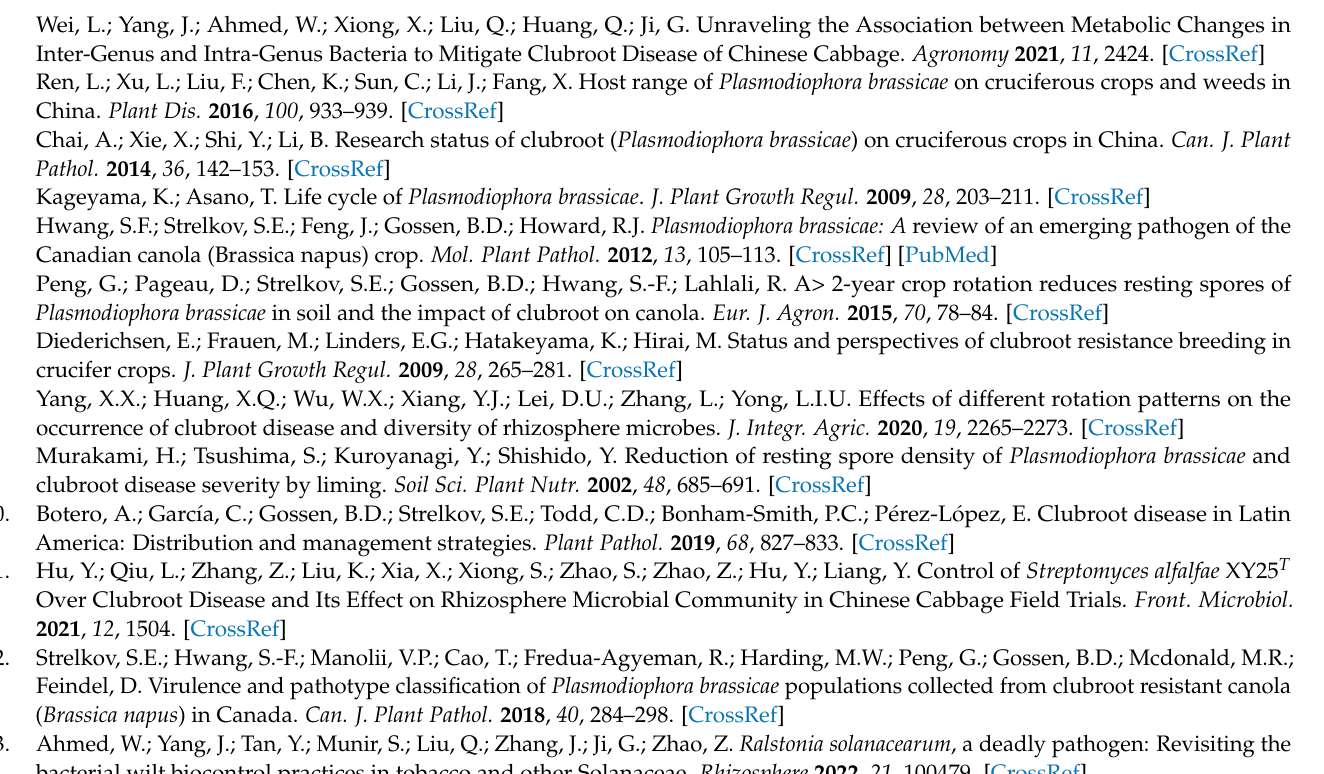
Table S1: Effect of bacterial biocontrol strains on the disease incidence, disease index, control effect, and soil pH of cabbage clubroot. Table S2: Effect of bacterial biocontrol strains on yield of Chinese cabbage. Table S3: Effect of single strains, intra/inter-genus co-culture, and microbial consortia on alpha diversity of bacterial community associated with the rhizosphere of Chinese cabbage ( ± SEM, n = 3/treatment). Table S4: Relative abundance of 10 most dominant phyla under different experimental conditions ( ± SEM, n = 3/treatment). Table S5: Relative abundance of 20 most dominant genera in rhizosphere soil under different experimental conditions ( ± SEM, n =